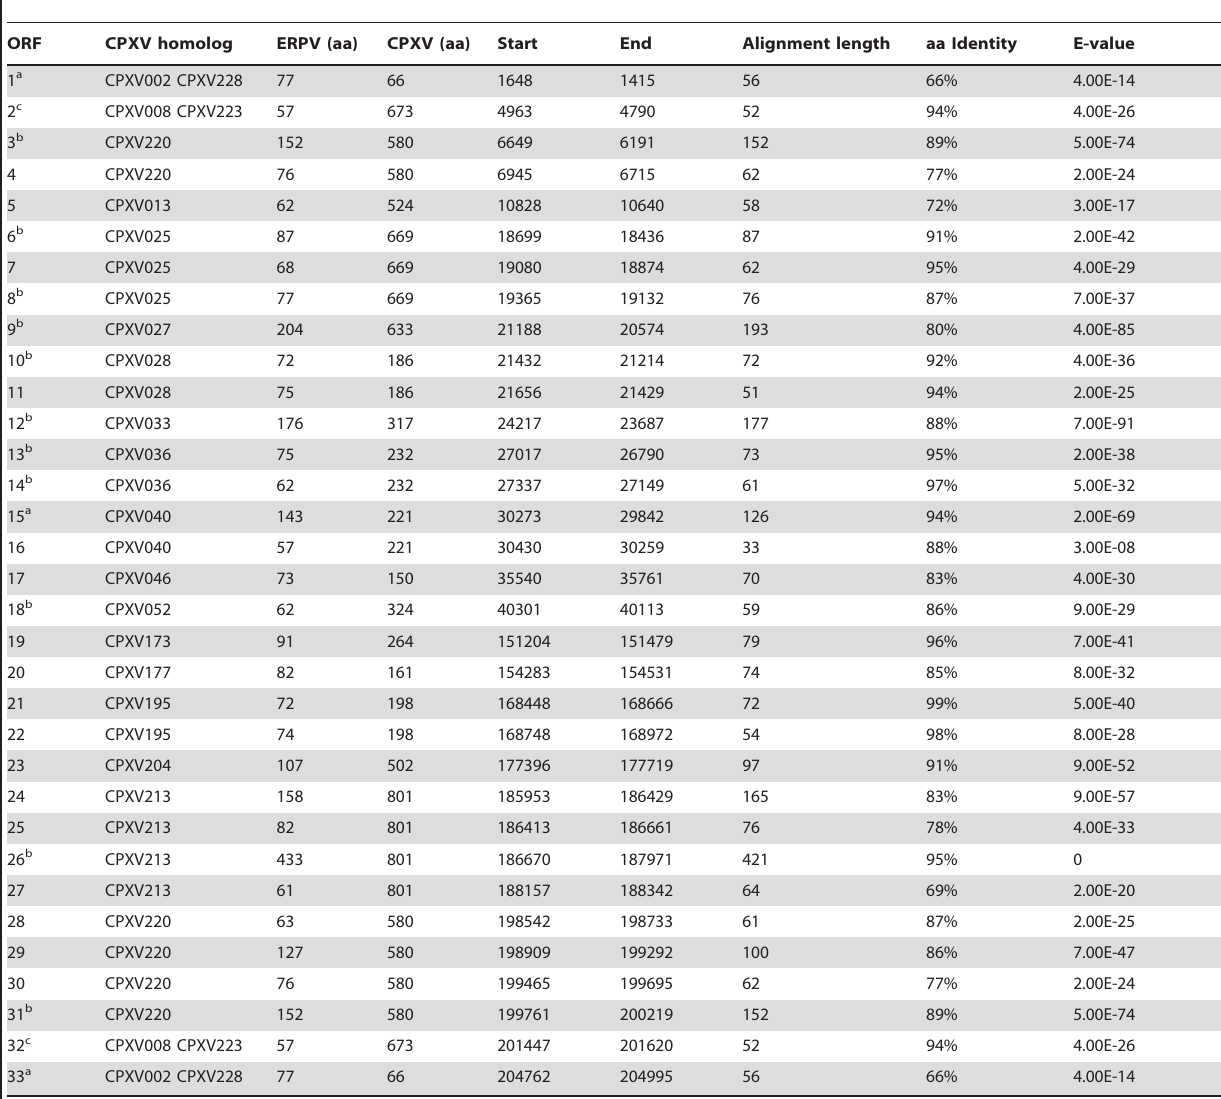
Table 3. Unassigned ORFs with homology to CPXV